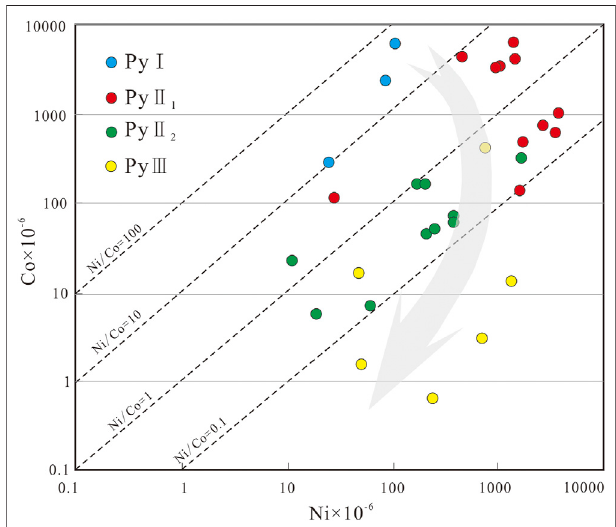
FIGURE 11 | Co-Ni genetic diagram for the different types of pyrite from the Tuwu porphyry Cu deposit in eastern Tianshan, Xinjiang, NW China.